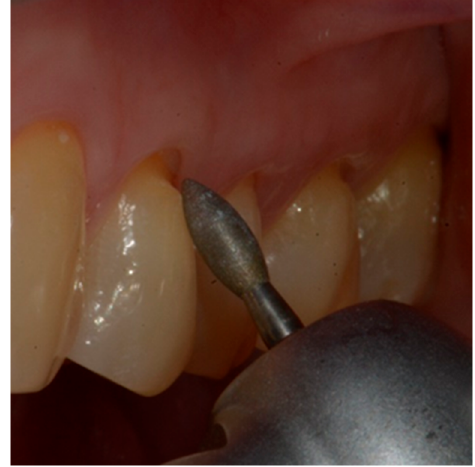
Figure 4. A small bevel was performed on the coronal margin of the NCCL.